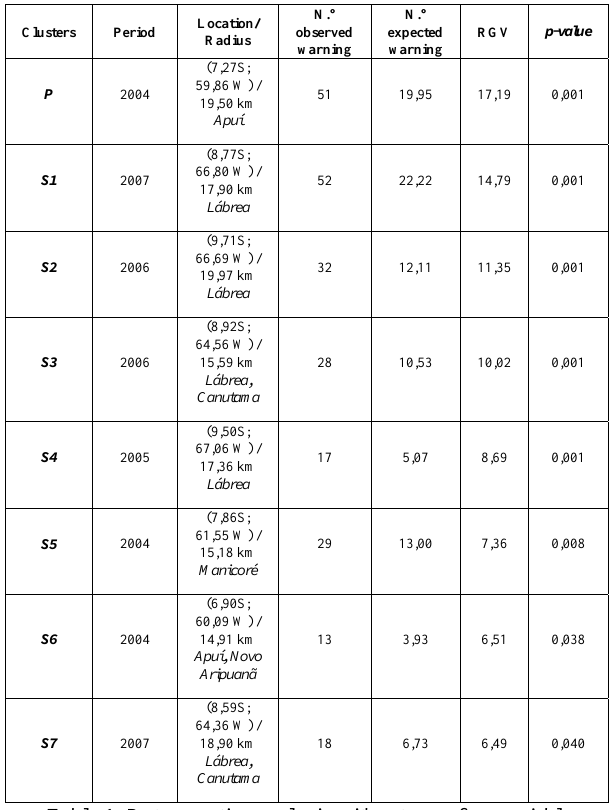
Table 1. Retrospective analysis without use of co-variable distance from roads.